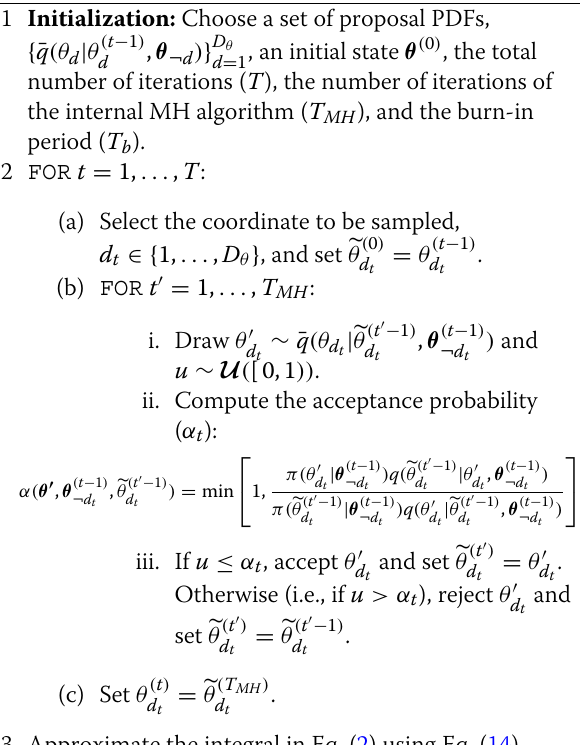
Algorithm 7 MH-within-Gibbs